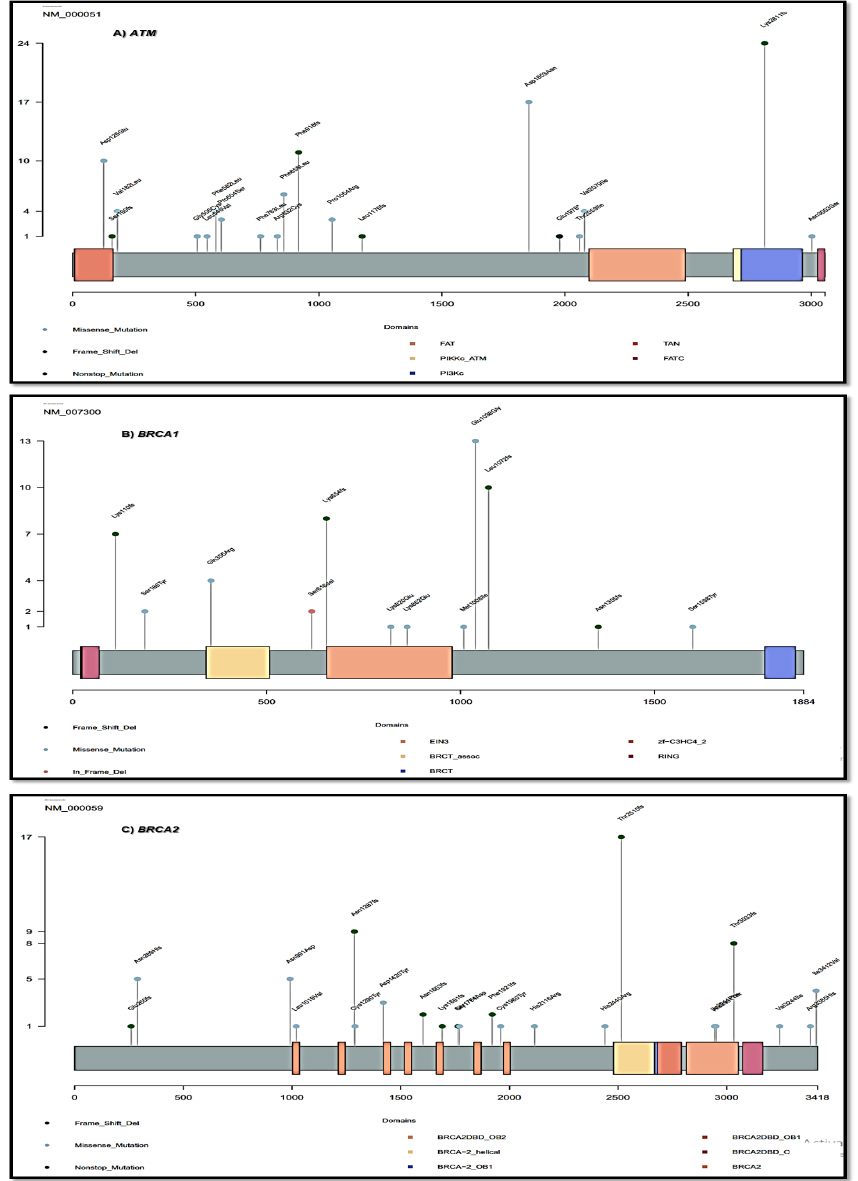
Figure 3. Schematic representation showing the position of the detected germline mutations in ( A ) ATM , ( B ) BRCA1 , and ( C ) BRCA2 genes. The mutations are colored with respect to their type.